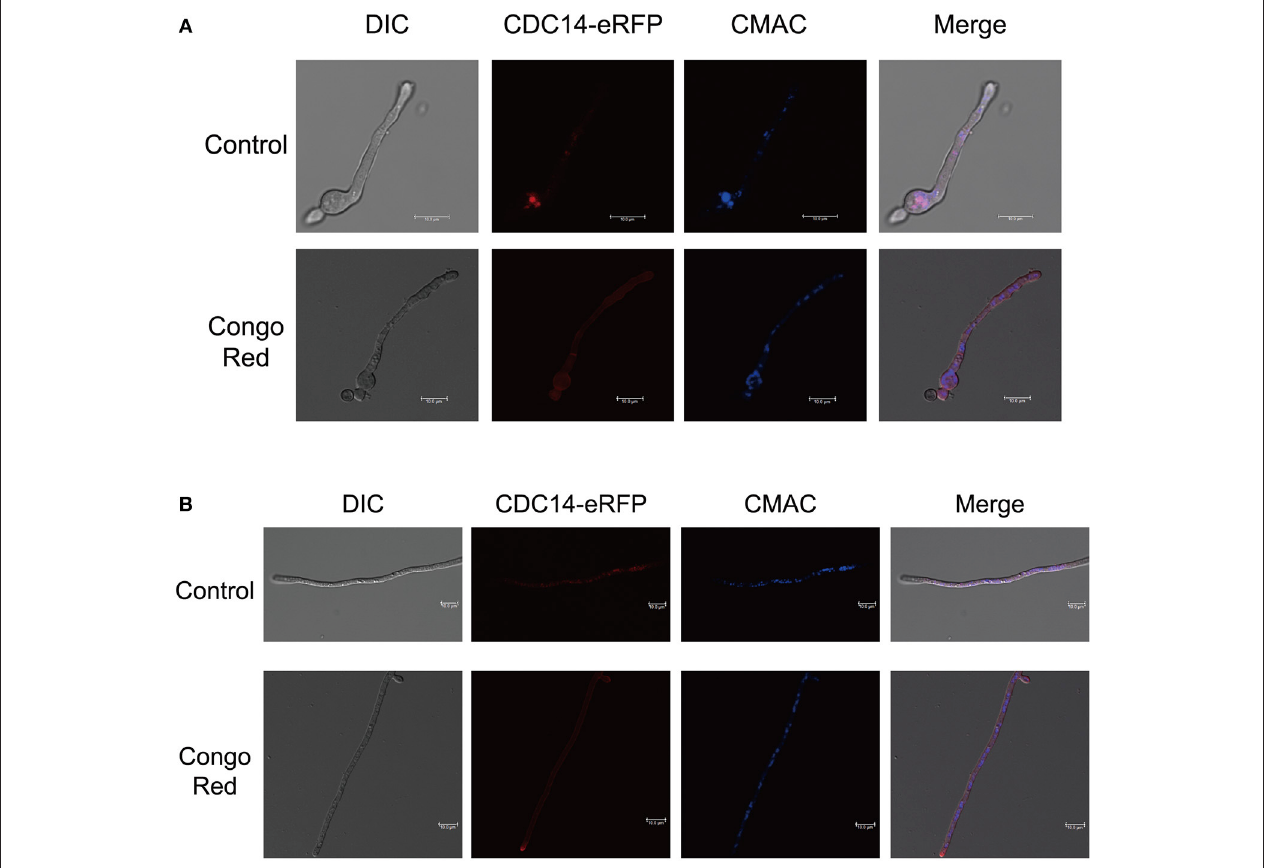
FIGURE 9 | Subcellular localization of AflCDC14-eRFP in A. flavus . (A) Fluorescent image of CDC14-eRFP during the conidia germination period. The CDC14-eRFP strain was grown for 12h at 37 ◦ C in PDB medium and transferred to congo red for 0.5h. The vesicles was stained by chloromethyl derivative of aminocoumarin (CMAC). bars = 10 µ m. (B) Localization of CDC14-eRFP in hyphal stages. The CDC14-eRFP strain was grown for 12h at 37 ◦ C in PDB medium and transferred to congo red for 0.5h. bars = 10 µ